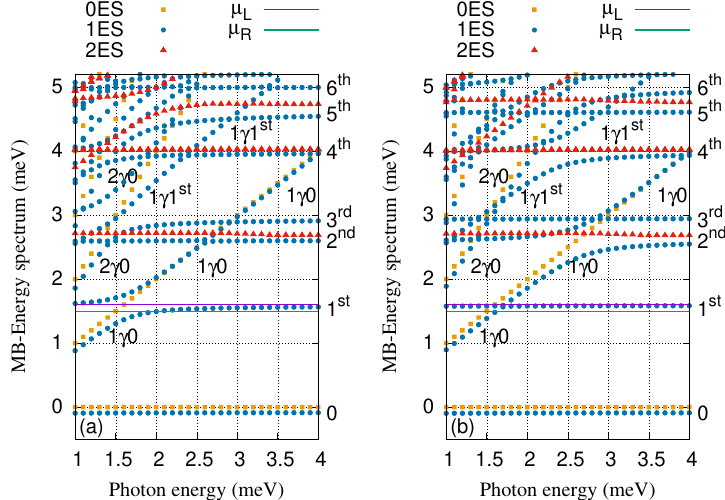
Figure 6. Many-Body energy spectra of the cavity-QD system versus the photon energy for x - ( a ) and y -polarized ( b ) photon field, where brown squares refer to zero-electron states (0ES), blue circles display one-electron states (1ES), and red triangles are two-electron states (2ES). The chemical potential of the left and the right leads are µ L = 1.65 meV (purple line) and µ R = 1.55 meV (green line), respectively. 0 is the one-electron ground-state energy, 1 γ 0 and 2 γ 0 demonstrates the one- and two-photon replica of the 0, and 1st, 2nd, 3rd, 4th, 5th, 6th indicate the one-electron first-, second-, third-, fourth-, fifth- and sixth-excited state, respectively. The 1 γ 1st indicates the one-photon replica state of the 1st. The photon number initially in the reservoir n R = 1, g γ = 0.3 meV, and κ = 10 − 5 meV. The magnetic field is B = 0.1 T, eV g = 0.651 meV, T L,R = 0.5 K and ¯ h Ω 0 = 2.0